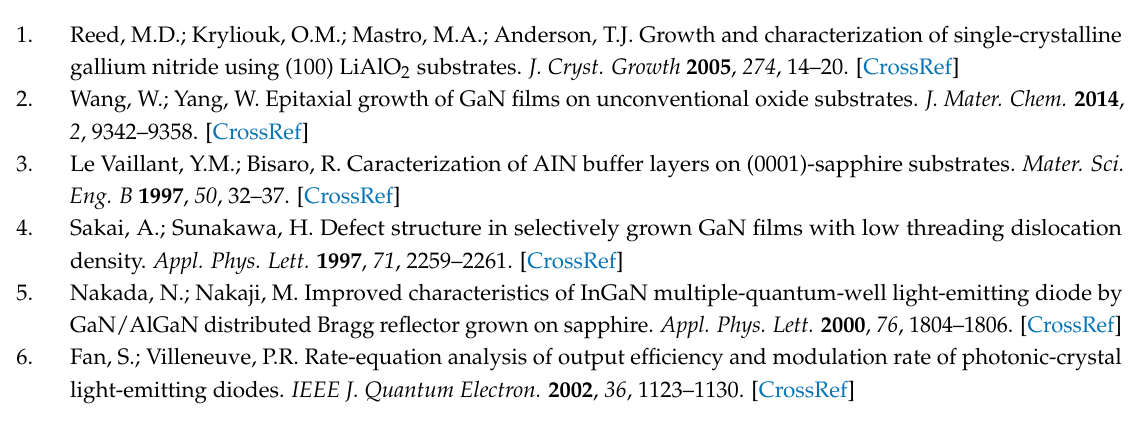
Figure 6. Absorption spectra measured at room temperature for c-plane GaN grown on striped PSS.